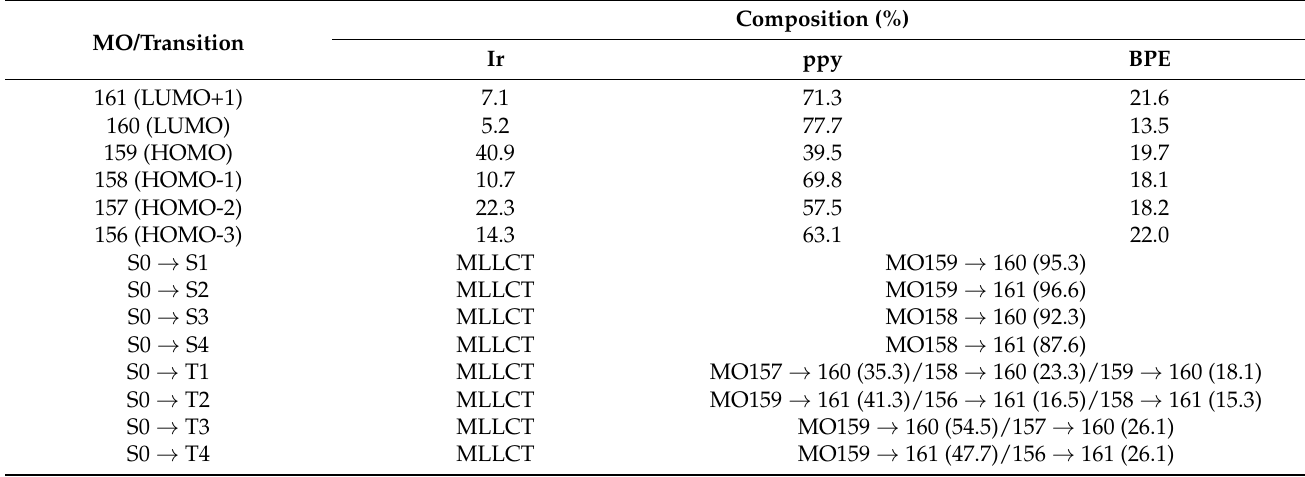
Table 4. Ir(ppy) 2 (TPP) percentage composition of singlet/triplet transitions and related molecular orbitals calculated at the RB3LYP/LANL2DZ level.